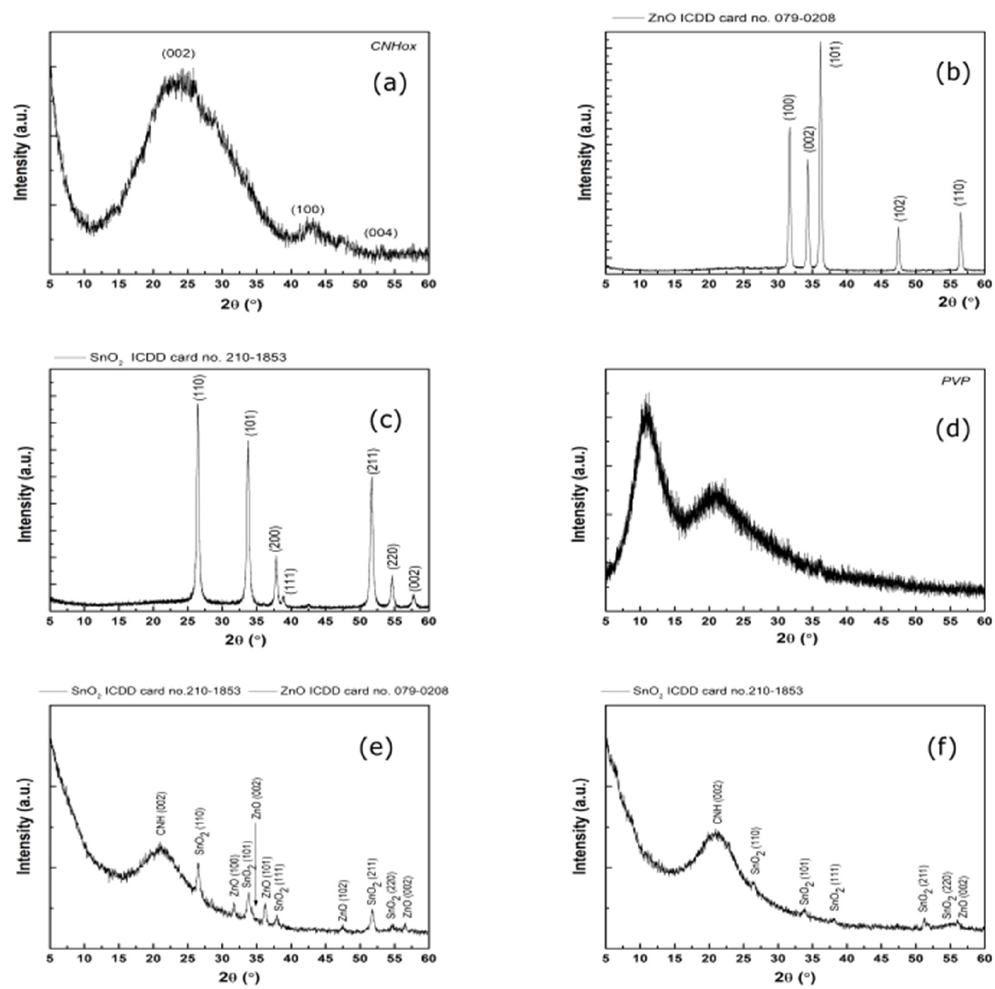
Figure 5. Diffractogram GIXRD for: ( a ) CNHox, ( b ) ZnO, ( c ) SnO 2 , ( d ) PVP, nanocomposite CNHox/SnO 2 /ZnO/PVP ( e ) (1.5/1/1/1 mass ratio) and ( f ) (3/1/1/1 mass